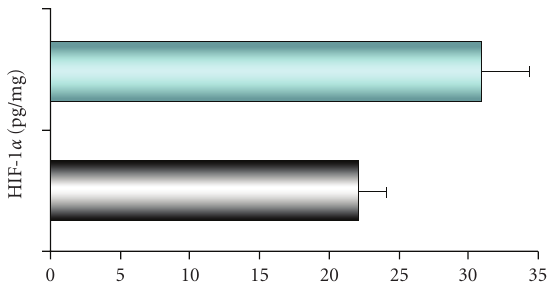
Figure 13: Detection of HIF-1 α protein by ELISA. The transfected group (top) had a higher concentration as compared with the nontransfected group.